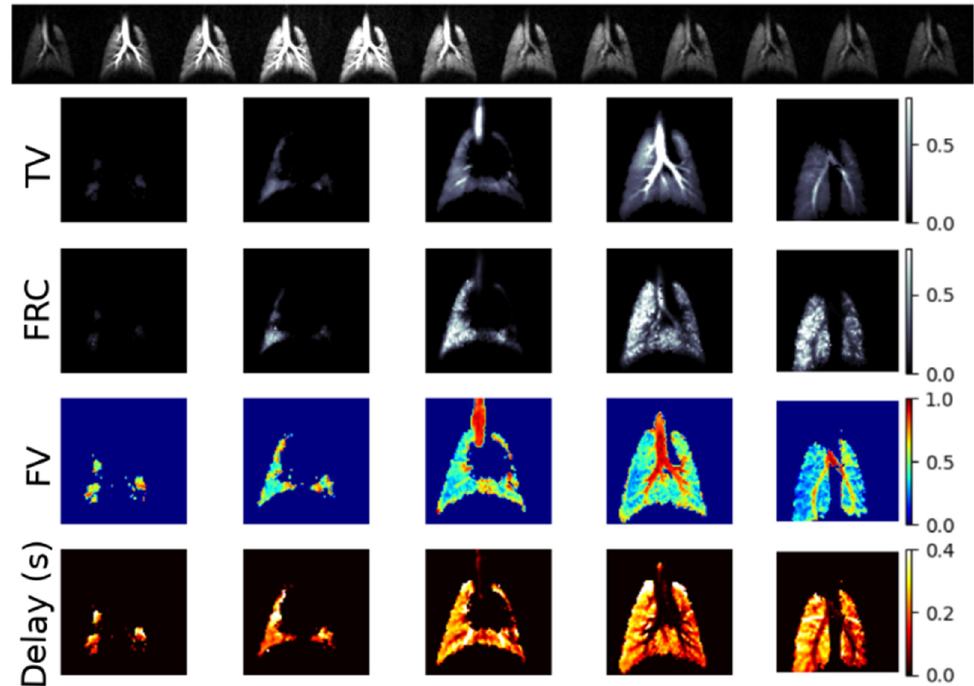
Figure 4. A series of images, assembled from acquisitions during ~100 breaths of 10% HXe during 3 min. free breathing in a healthy pig. The top row shows signal dynamics during a typical breath; signal appears in the trachea and large airways first on inhalation (top row, left) and is distributed to the parenchyma more slowly. Analysis of signal dynamics according to Equations (1) and (2) yields maps of local TV, and FRC (rows 2,3), the ventilation efficiency (row 4), and time required for the parenchymal region to reach full inspiratory volume (row 5). The latter parameter may be particularly useful in highlighting obstructed flow and abnormal breathing dynamics due to compromised lung compliance, musculoskeletal changes or the Pendelluft effect.